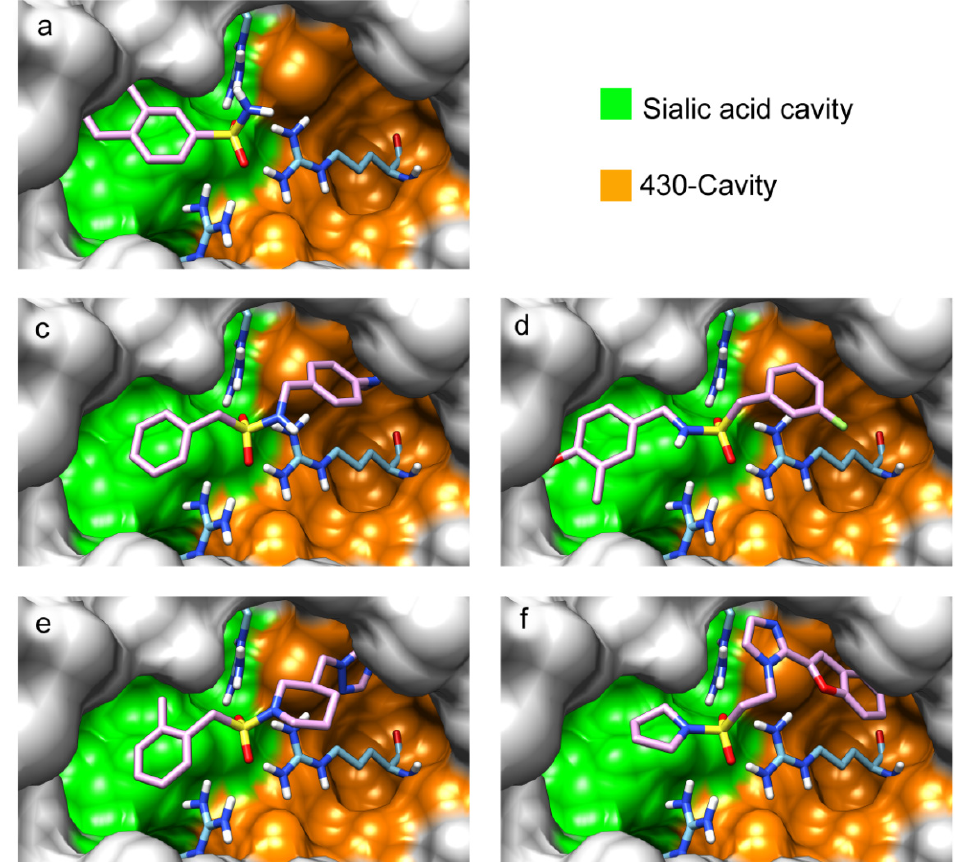
Figure 6. Typical positions of unsubstituted ( a ), monosubstituted ( c , d ) and disubstituted ( e , f ) sulfonamides selected by virtual screening of the ZINC12 library against N1 neuraminidase. a —ZINC13686935, c —ZINC13673669, d —ZINC68909486, e —ZINC97048161, f —ZINC77458684. Designations a – f correspond to orientations of molecules presented in Table